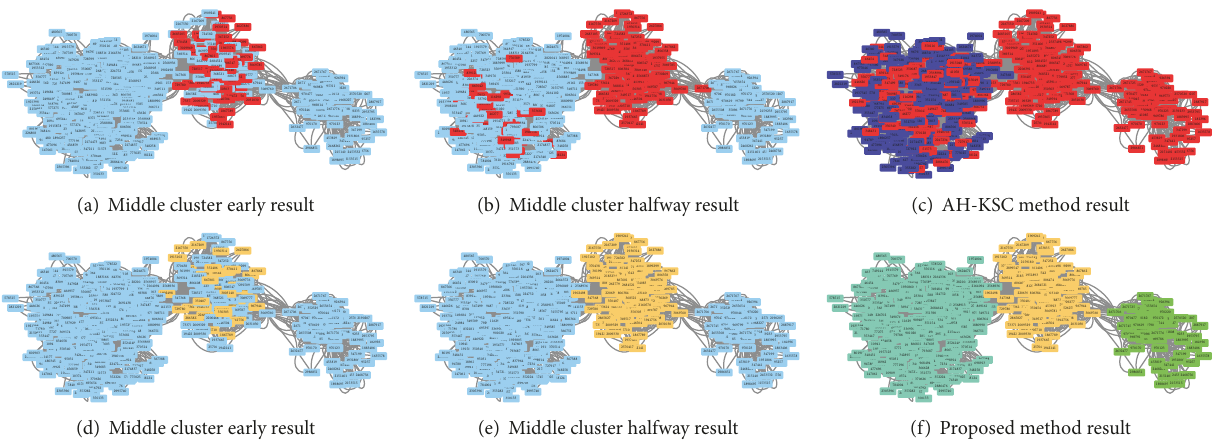
Figure 4: Analysis of agglomeration process. (a, b, c) AH-KSC method. (d, e, f) Proposed method.